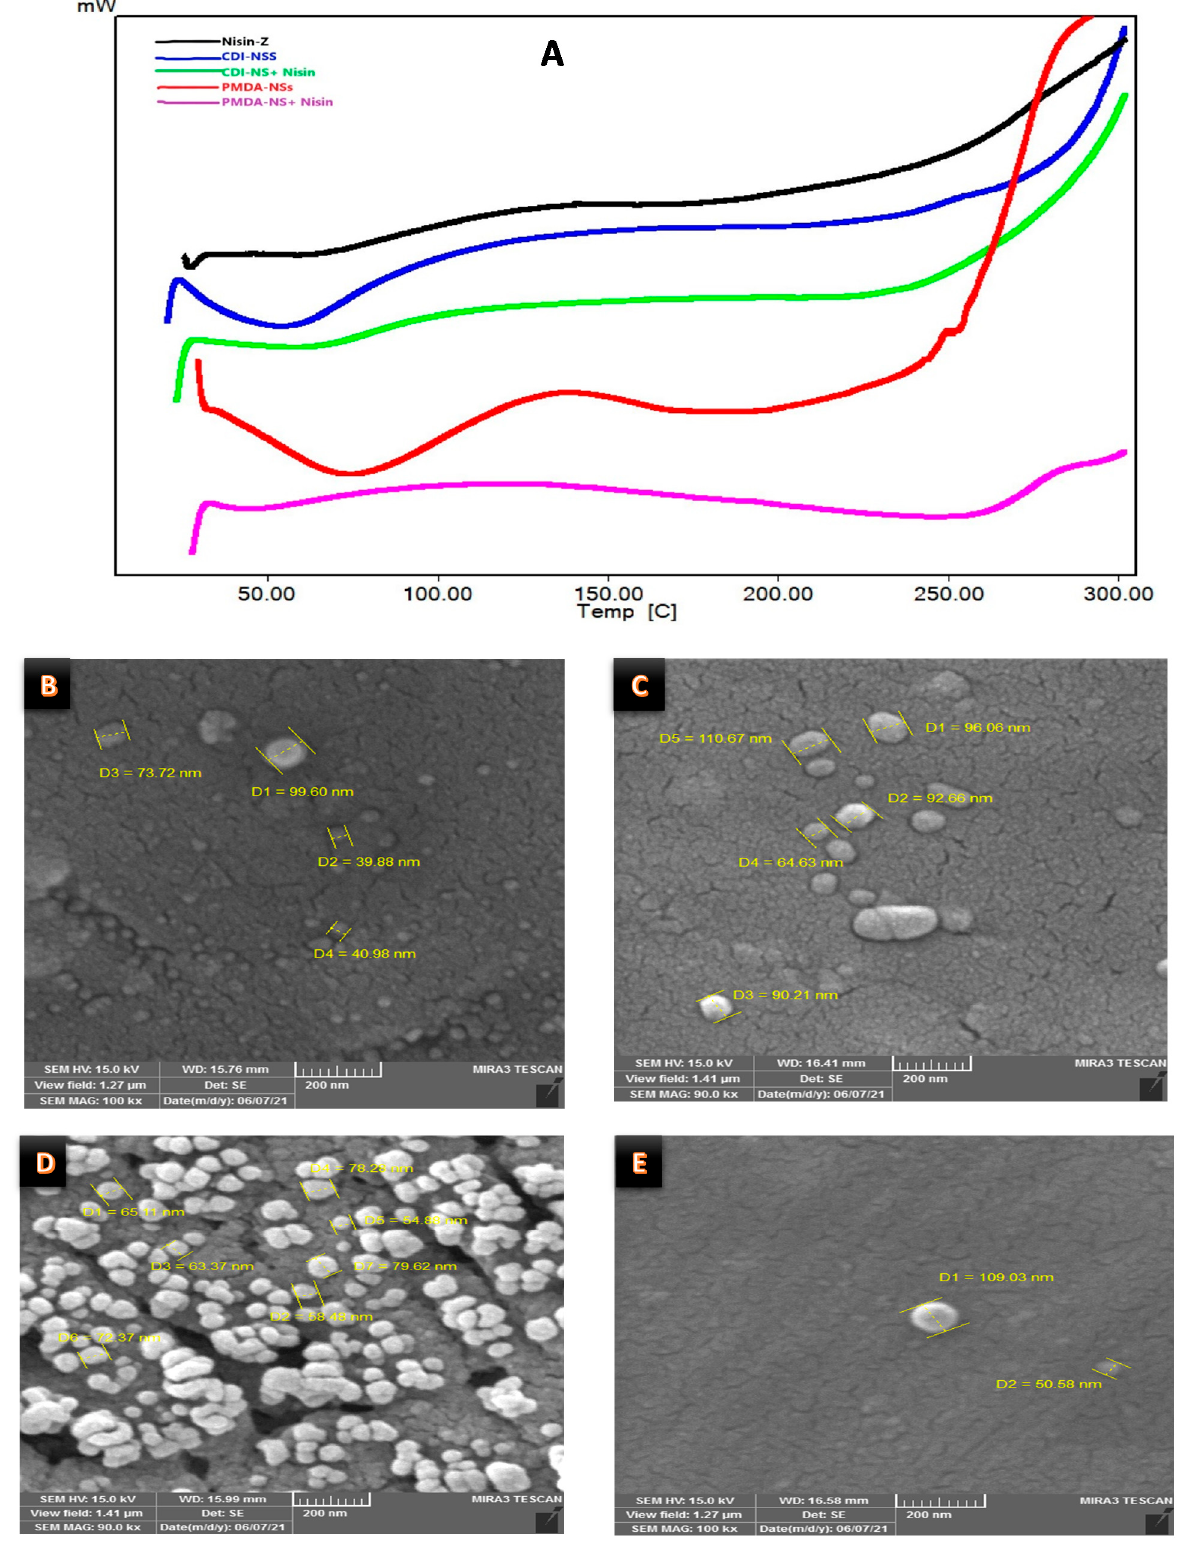
Figure 1. Physicochemical characterization of Nisin-Z and complexes. ( A ) DSC thermograms of Nisin, Nisin/PMDA-NSs, and Nisin/CDI-NSs, SEM images; ( B ) CDI-NSs, ( C ) Nisin/CDI-NSs, ( D ) PMDA-NSs, ( E ) Nisin/PMDA-NSs.